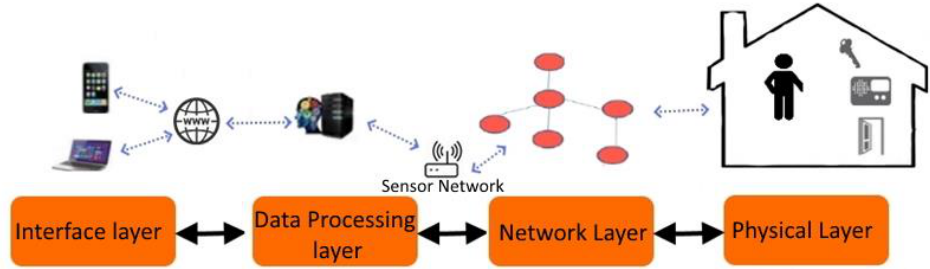
Figure 3. Multilayered architecture of a smart home. The figure was taken from